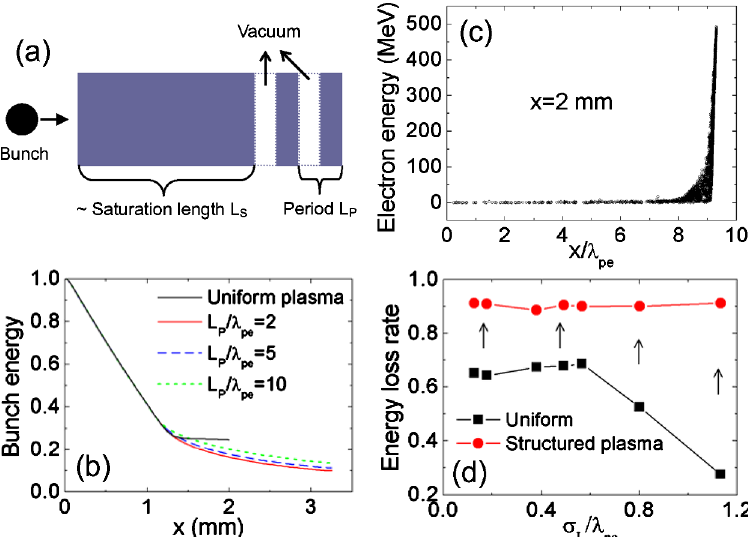
FIG. 3. Suggested beam dump. (a) The proposed structured plasma consisting of a stopping layer with thickness L s and periodic plasma slabs separated by a vacuum gap. L p is the period of the structured plasma. In each period, the plasma slab length is equal to the vacuum length. (b) Evolution of bunch energy for both uniform plasma and structured plasma with L P =(cid:5) pe ¼ 2 , 5, and 10. (c) Electron energy vs x position at x ¼ 2 mm for the case of L P =(cid:5) pe ¼ 2 . (d) Improvement of energy loss rate due to the structured plasma for different plasma densities plotted in terms of (cid:4) L =(cid:5) pe , keeping bunch sizes (cid:4) T ¼ 10 (cid:6) m and (cid:4) L ¼ 3 (cid:6) m